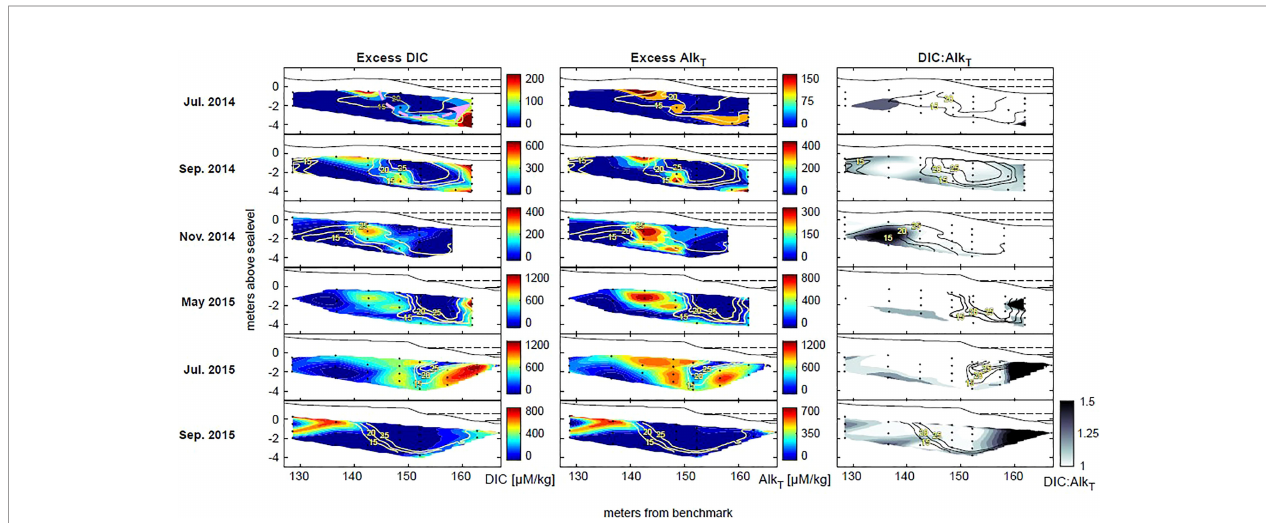
FIGURE 4 | Spatial distribution of excess DIC and T-Alk, and DIC : Alk T ratios over seasonal timescales. Salinity 15, 20, and 25 contours are shown. Higher ratios are often found along freshwater-seawater mixing areas due to aerobic respiration, and subsequent anaerobic respiration supported by oxidants in freshwater. High DIC : Alk T ratios near the discharge zone (seaward samplers near the 160 m mark) are due to high sulfate reduction activity. Solid black line indicates topography, with mean high-tide and mean sea-level indicated with dotted horizontal